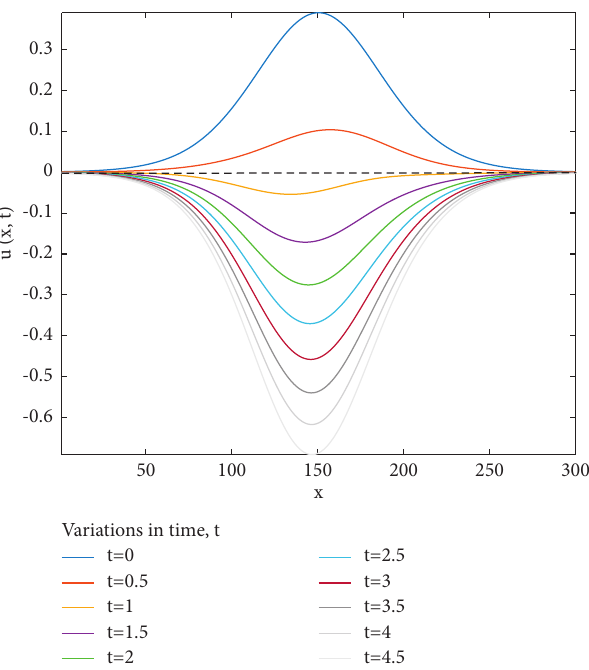
Figure 4: 2D fractional temporal numerical solution u ( x ) for order α � 0 . 6, κ � 4, and δ �